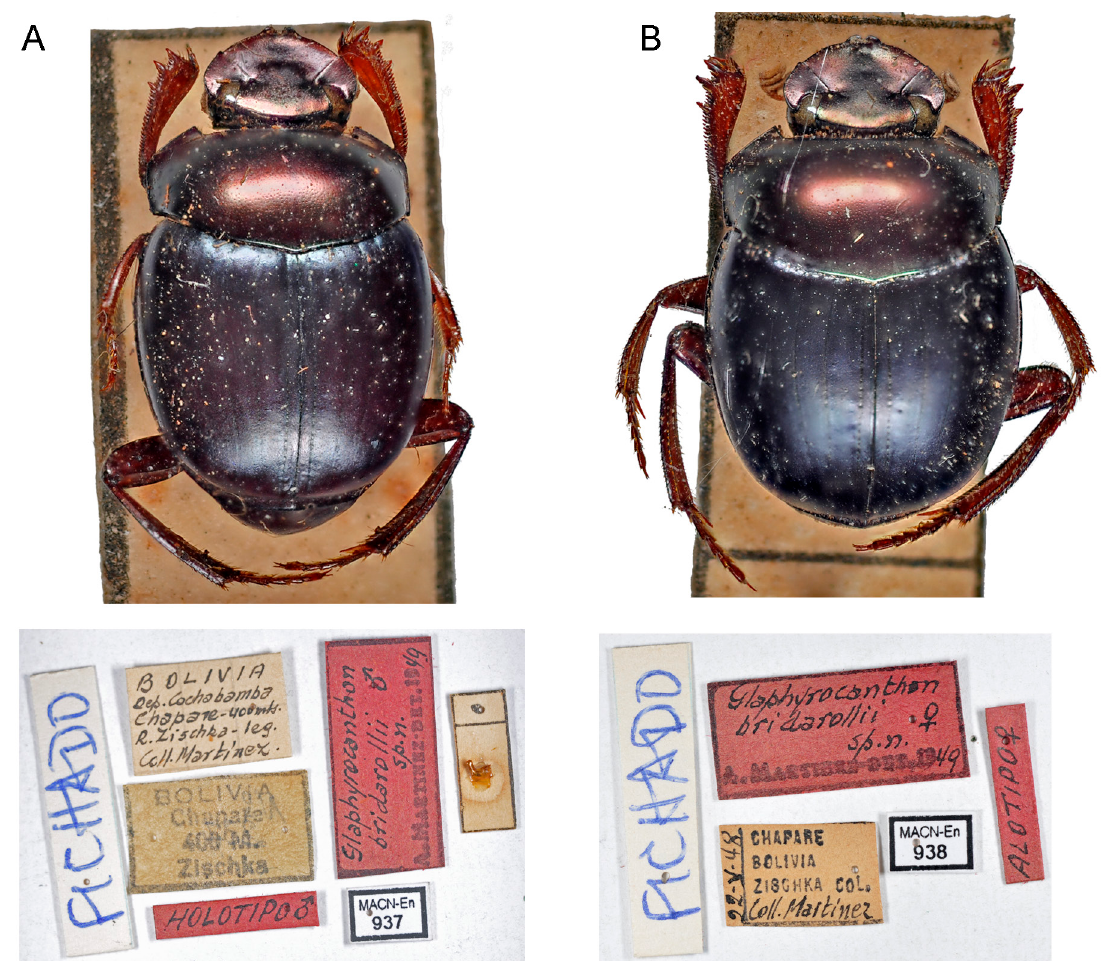
Fig. 33. Sylvicanthon bridarollii (Martínez, 1949) type material. A . Holotype and its labels. B . Allotype and its